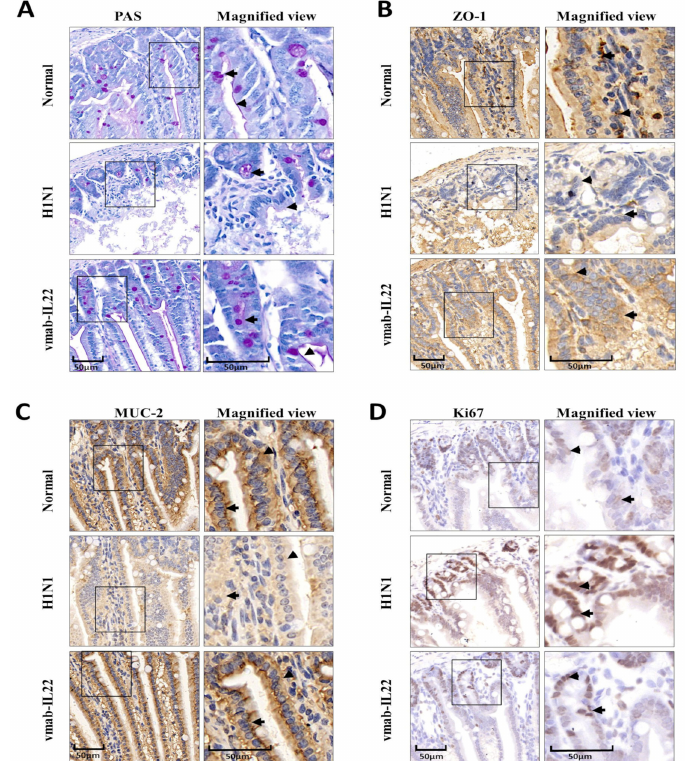
Figure 2. Vmab-mIL22 treatment improves intestinal epithelial repair and promotes regeneration. Male BALB/c mice were infected with the H1N1 virus and then intravenously treated with vmab- mIL22 twice in 4 days. Positive cells are indicated by triangles and arrows. ( A ) Staining for PAS, ( B ) ZO-1 expression, ( C ) MUC-2 expression and ( D ) the expression of Ki-67 protein in the small intestine were measured using IHC ( n = 4). PAS, Periodic Acid-Schiff stain; ZO-1, zonula occludens protein 1; MUC-2,